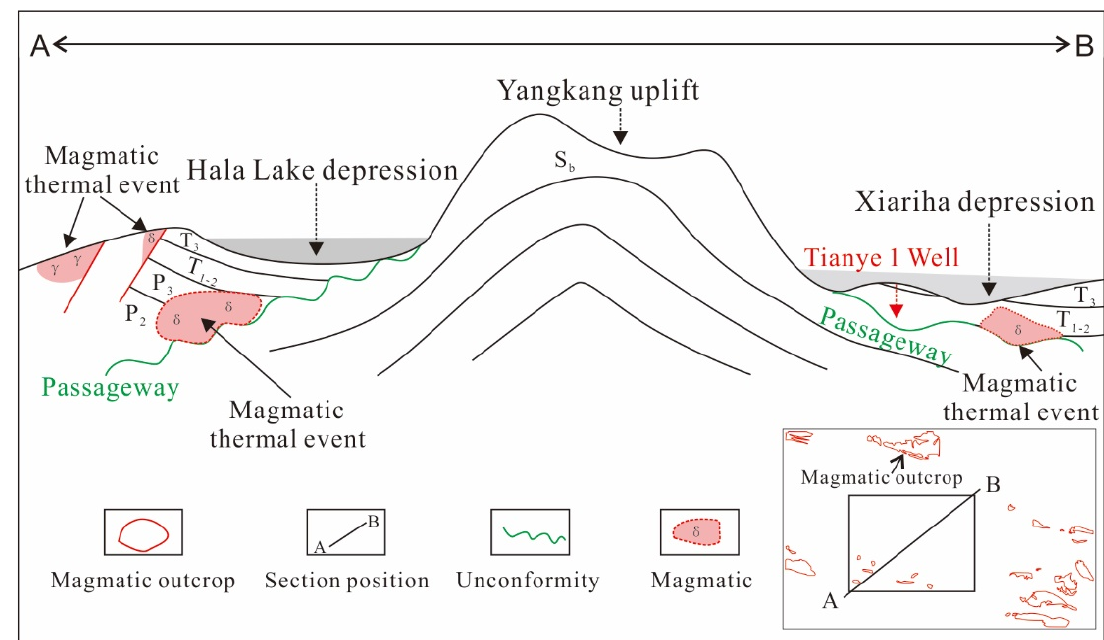
Figure 9. The model map of the magmatic thermal events in the study area.